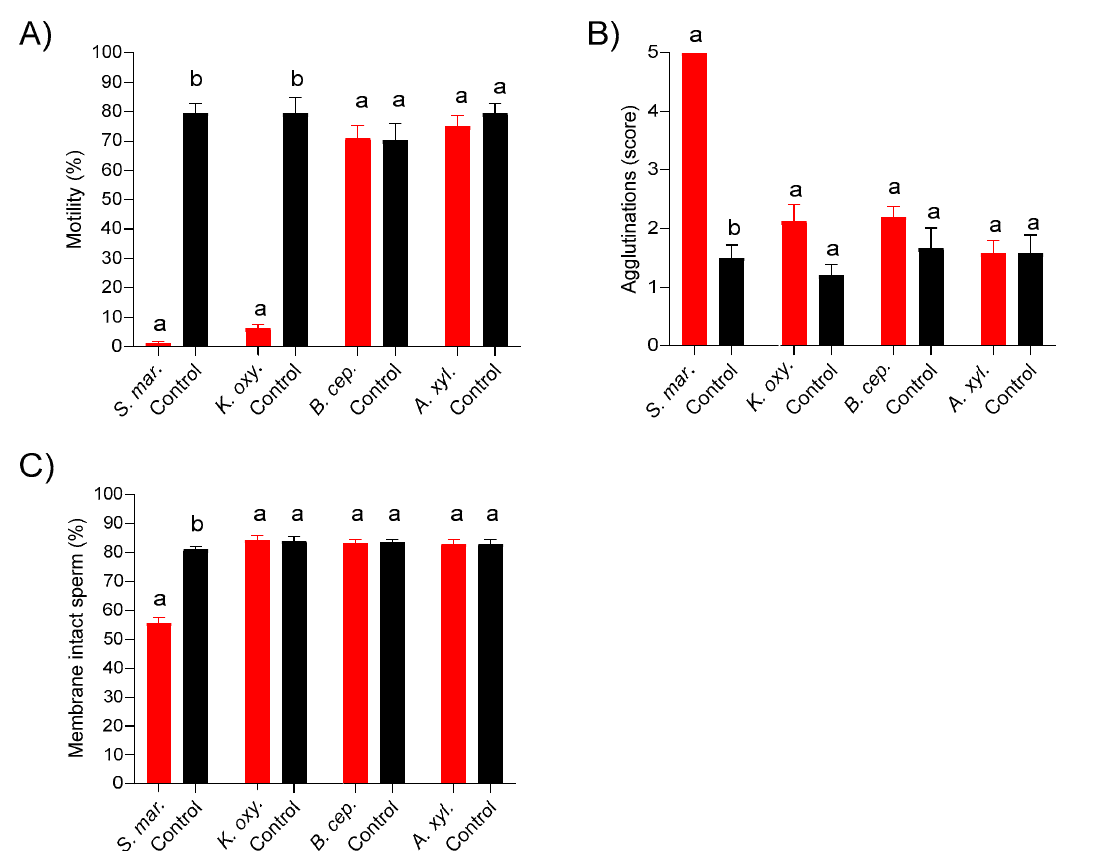
Figure 3. Sperm motility ( A ), agglutination ( B ), and sperm membrane integrity ( C ) in extended semen spiked with four different multidrug-resistant bacterial species at ~10 3 CFU/mL and stored for 144 h. The samples extended in Beltsville Thawing Solution were stored at 17 ◦ C. Data are means and SEM ( S. marcescens : n = 6; other bacteria: n = 8). a, b: Different lowercase letters indicate differences between spiked samples and controls ( p < 0.05).